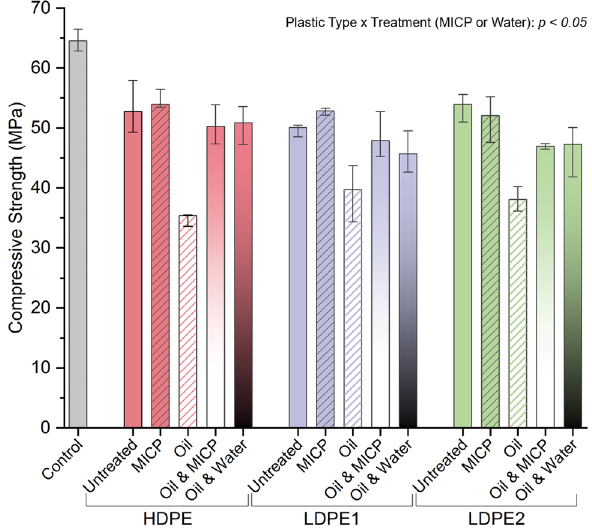
Figure 7. Compressive strengths at 10% volume replacement with waste plastic types HDPE (red), LDPE1 (purple), and LDPE2 (green). Each type of plastic was subjected to five treatments: no treatment (solid), MICP- treated plastic (solid and striped), oil-coated plastic (white and striped), oil-coated and MICP-treated plastic (white to solid), oil-coated and washed with water plastic (black to solid). The bars represent the mean values, and the error bars indicate one standard